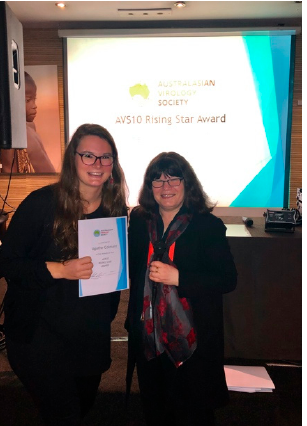
Figure 3. Dr. Agathe Colmant ( left ) receiving the AVS10 Rising Star Award presented by AVS President Professor Gilda Tachedjian ( right ).